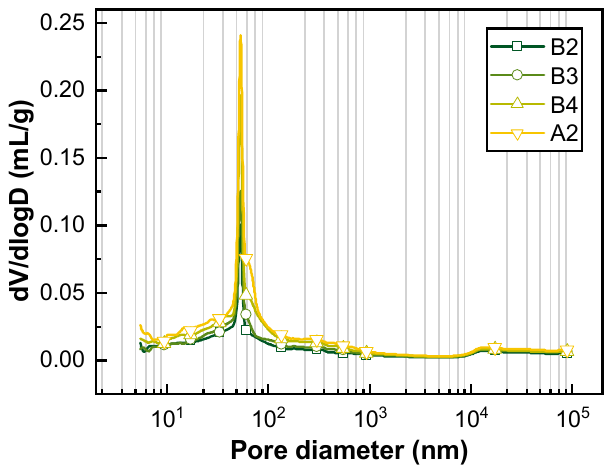
Figure 7. The pore distributions of concrete with different levels of fatigue damage.